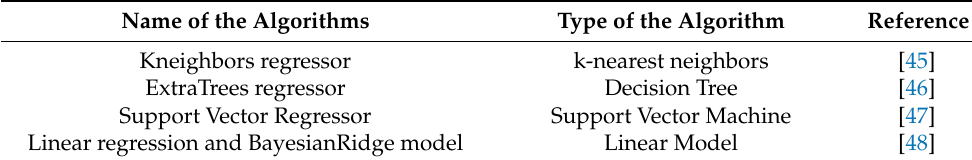
Table 6. Details of the algorithms used.